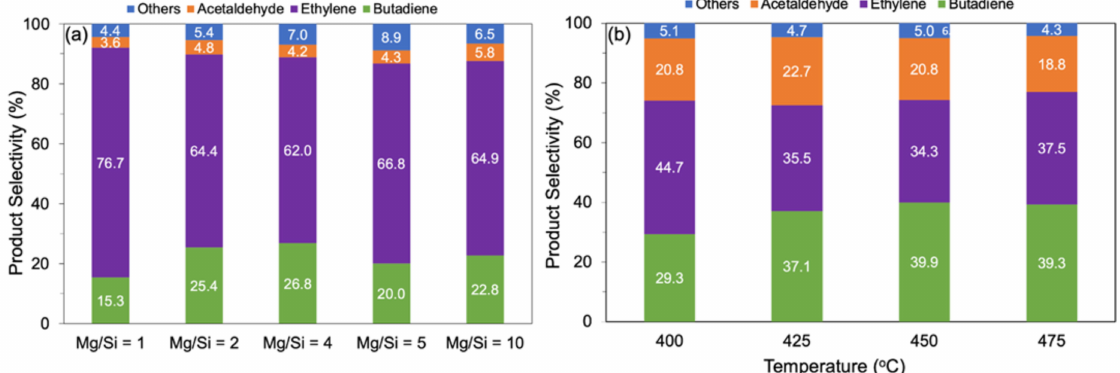
Figure 6. Product distribution ( a ) as function of composition over MgO-SiO 2 (AE) with different Mg/Si ratios at 475 ◦ C and ( b ) as function of temperature over MgO-SiO 2 -4 (AE). Reaction condi- tions: 0.1 g catalyst, 1.5 g glass beads, 55 mL/min He, time-on-stream = 4 h, ethanol concentration ( a ) 100 µ L/h (3.2 vol%) and ( b ) 400 µ L/h (11.3